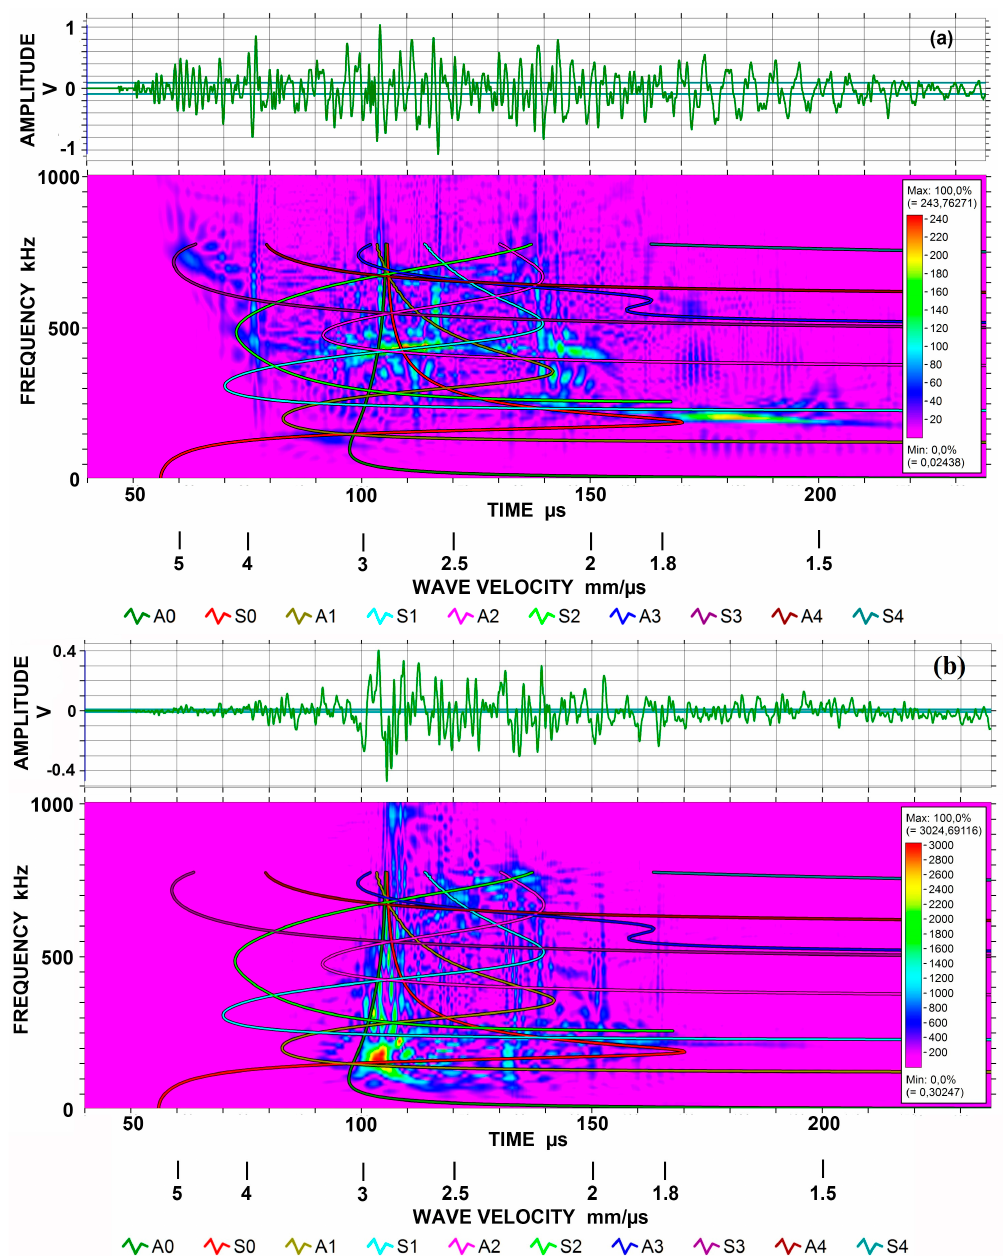
Figure 4. ( a ) Choi-Williams transform spectrogram for symmetrically excited Lamb waves on 12.7 mm-thick plate using KRN sensor. The output of 40–200 µs segment up to 1 MHz shown. ( b ) As ( a ), but for asymmetrically excited Lamb waves on 12.7 mm-thick plate.